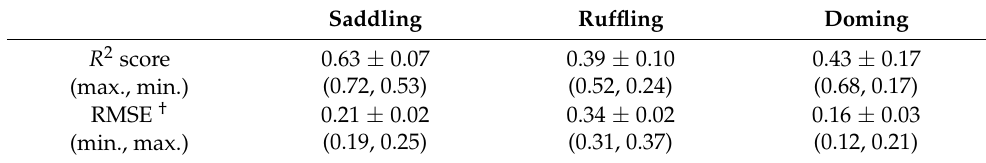
Table 4. Results of prediction by the model which takes voxels with one-channel as an input.